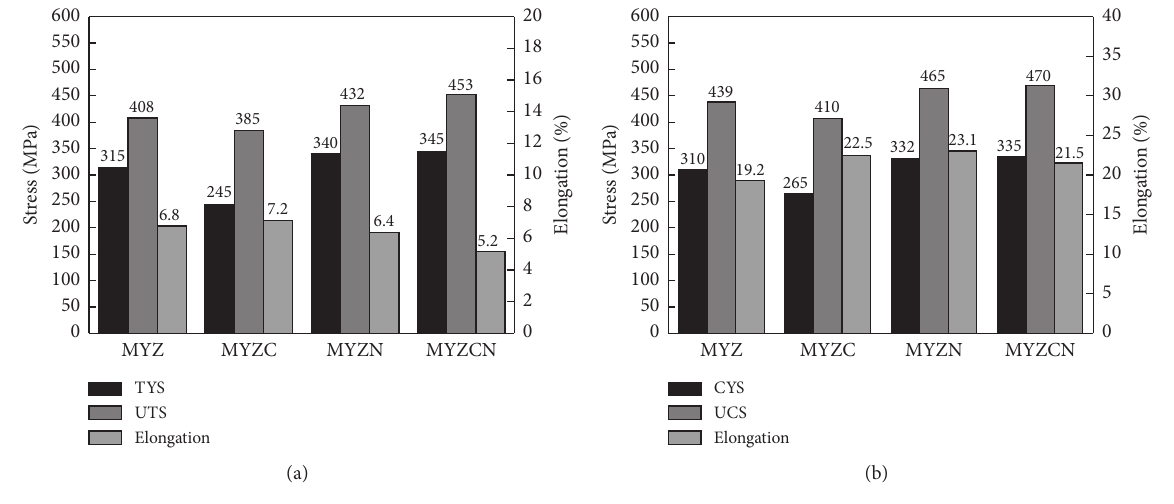
Figure 6: Mechanical properties of the extruded